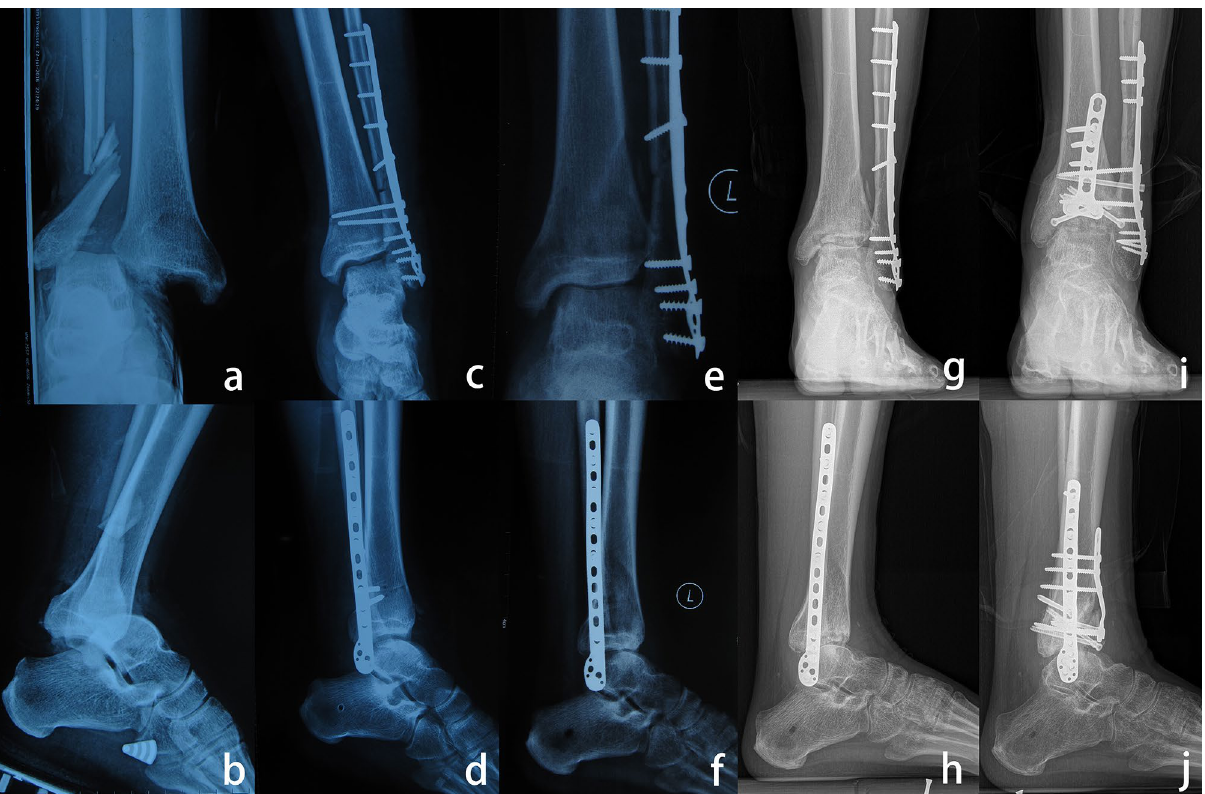
Figure 2. ( a,b ) A 34-year-old man sustained an open Weber type C ankle fracture. ( c,d ) ORIF was performed at 10 days after injury, and the distal tibia plafond was initially intact. ( e,f ) As the initial operation failed to reduce the fibula and distal syndesmosis anatomically, the talus was still anteriorly translated after the initial surgery. ( g,h) . The anterior distal tibial plafond gradually became impacted as weightbearing was initiated. ( I,j ) Two years after realignment surgery, the ankle was normally aligned, and the patient was satisfied with the results of the could be made just at the medial corner. Then, a wide osteotome was used to open the osteotomy to fully expose the impacted articular surface. A second osteotomy was required just above the impacted subchondral bone, and a small chisel was utilized to meticulously reduce the step-off of the articular surface under direct vision. An allograft was used to fill the osteotomy gap. The anterior distal tibial fragment was slid distally, and the osteotomy was opened until a congruent ankle joint was achieved, as confirmed intraoperatively under fluoroscopy. The allograft was reinserted into the osteotomy gap, and Kirschner wires were utilized for temporary fixation of the anterior distal tibial fragment. Excessive bone was resected to match the contour of the anterior tibial surface. Cannulated screws and buttress plates were utilized to secure the osteotomy (Figs. 4, 5). Malunion of the fibula is also a common scenario, often involving shortening or rotation of the lateral malleolus 26,27 . In this study, a fibular osteotomy was performed in 10 patients. A horizontal fibular osteotomy was used because it was the easiest way to correct both shortening and rotational deformity of the fibula 6 . An allograft was inserted if the fibula needed lengthening. In addition, a supramalleolar osteotomy was performed in 6 patients; it was indicated to correct the TAS angle to 85° to 90° (Fig. 6) 28 . Ligament reconstruction would provide extra stability for the ankle joint. We routinely assessed ankle stability intraoperatively after bony cor- rections. Lateral ligament reconstruction was performed in 12 patients. The modified BrostrÖm procedure with suture anchors was used in 4 patients, while lateral ligament reconstruction was performed with allografts in the remaining 8 patients with inadequate soft tissue. Three patients needed extensive soft tissue release extending to the medial ankle ligaments, and medial ligament reconstruction with suture anchors was mandatory to enhance the stability of the ankle joint following plafond-plasty. Postoperative rehabilitation. The ankle was stabilized in the neutral position with a well-padded, short leg splint. The wound was inspected on the second day after the operation, and a walking boot was applied. Nonweightbearing range of motion exercise was initiated at one or two weeks after the operation when tolerated. Partial weightbearing with the protection of the walking boot was encouraged at six weeks after the operation with gradual progression to full weightbearing at three months after the operation. Statistical analysis. Statistical analyses were performed using IBM SPSS Statistics, version 23.0 (IBM Corp., Armonk, New York). The normality of the data, including the pre- and postoperative radiological param-